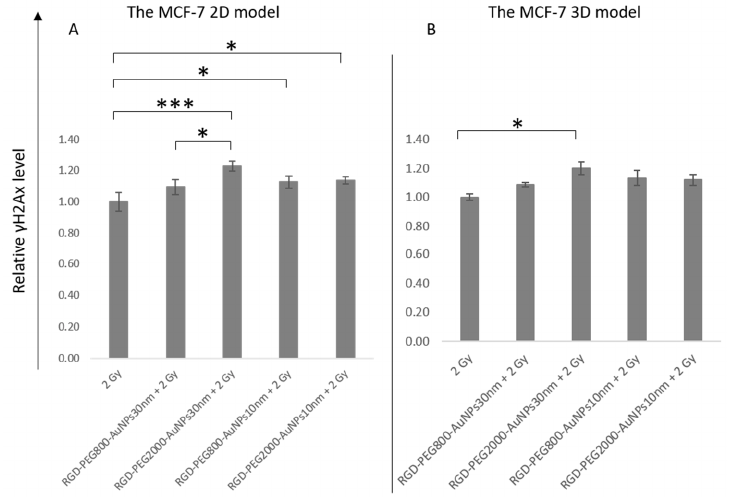
Figure 9. The γ H2AX relative level of the MCF-7 cells after exposure to a dose of 2 Gy and dose of 2 Gy with the previous 50 min incubation with RGD-PEG 800 -AuNPs 10nm , RGD-PEG 2000 -AuNPs 10nm , RGD-PEG 800 -AuNPs 30nm , and RGD-PEG 2000 -AuNPs 30nm in the concentration of 0.0008 mg/mL. ( A ) Results for the MCF-7 2D model and ( B ) for the MCF-7 3D model. The setting of the p -value * p < 0.05, *** p < 0.001.